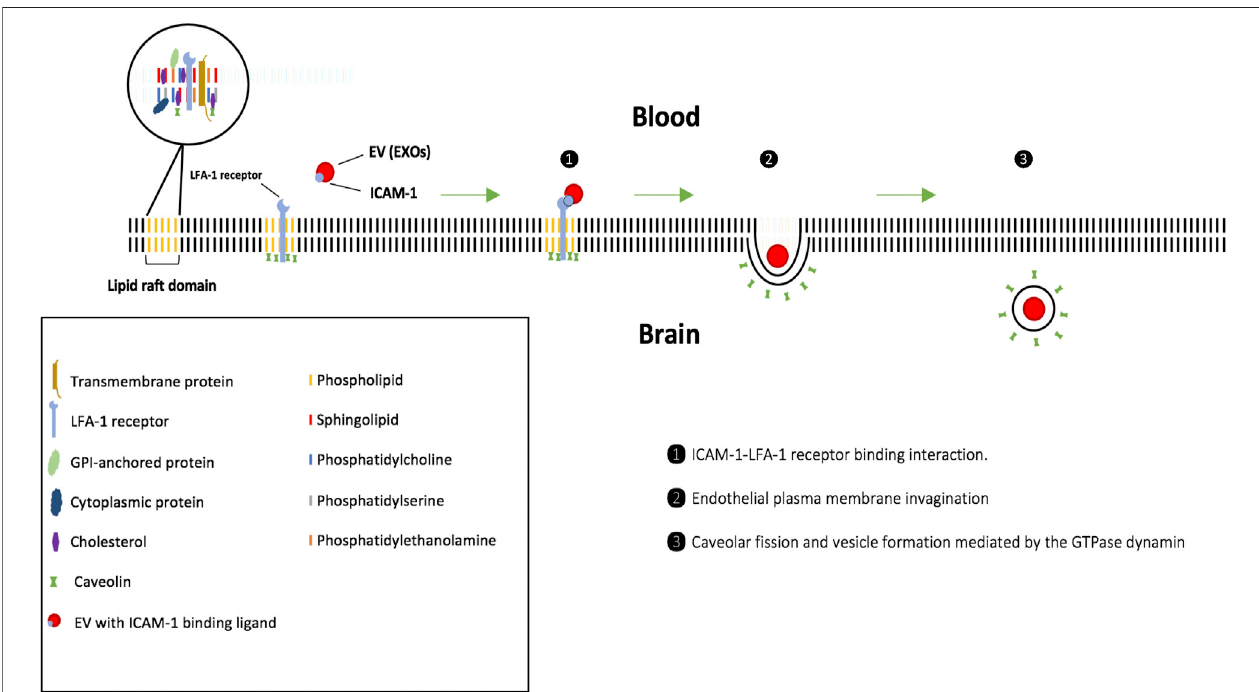
FIGURE 2 | EV uptake via receptor-mediated endocytosis involving lipid rafts and caveolae (clathrin-independent). 1) Upon binding to the cell surface, EXOs travel along the endothelial plasma membrane toward the caveolae invaginations, where they are maintained through ICAM-1 ligand-LFA1 receptor interactions. 2) Fission of the caveolae from the membrane, mediated by the GTPase dynamin, then generates the cytosolic caveolar vesicle. 3) Caveosome is formed and does not undergo lysosomal degradation, and, therefore, may be advantageous for EXOs carrying cargo highly sensitive to enzymes.